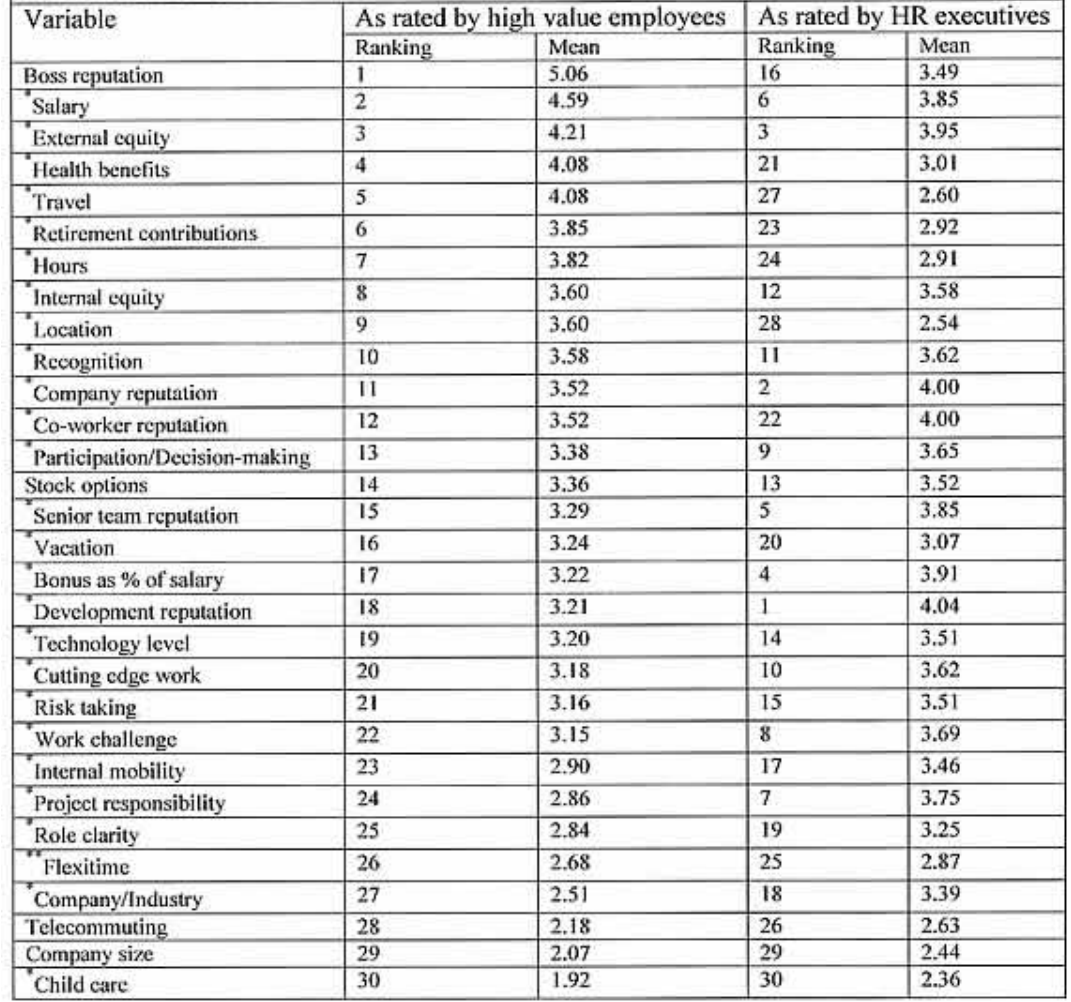
Table 2 Career decisions: compensation and so much